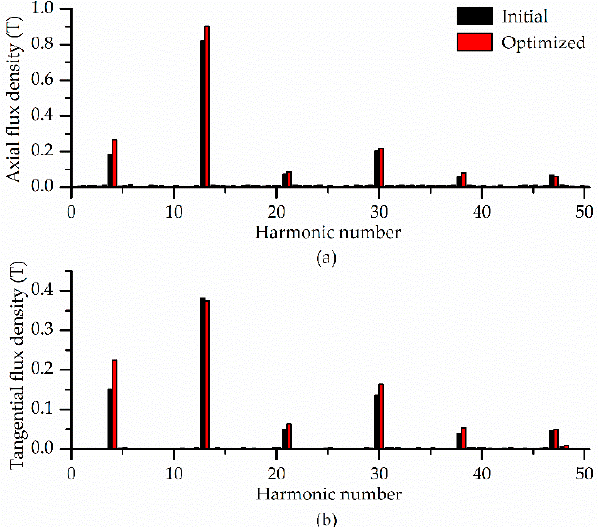
Figure 15. FFT analysis of the axial and tangential flux densities at the radius of R m5 in the LG of the HAMG. ( a ) Axial flux density; ( b ) Tangential flux density. Table 9. Amplitudes, phase differences and torque due to the air-gap flux density at the radius of R m3 .